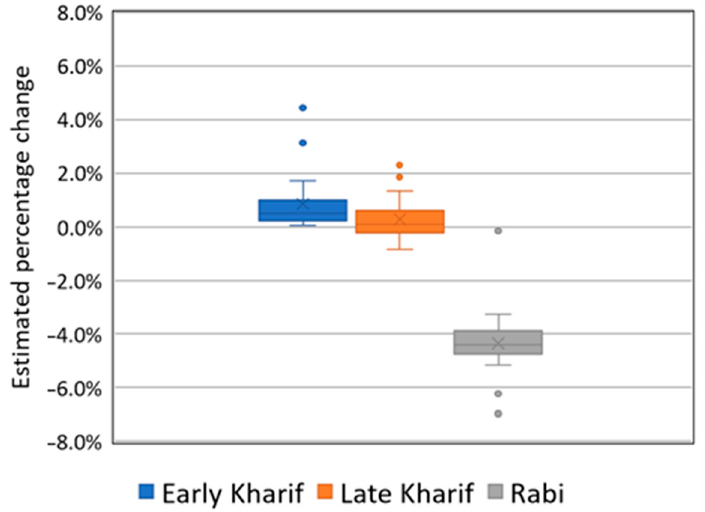
Figure 13. Estimated percentage change in seasonal canal deliveries to Punjab and Sindh between 1990 and 2020 sedimentation level scenarios.